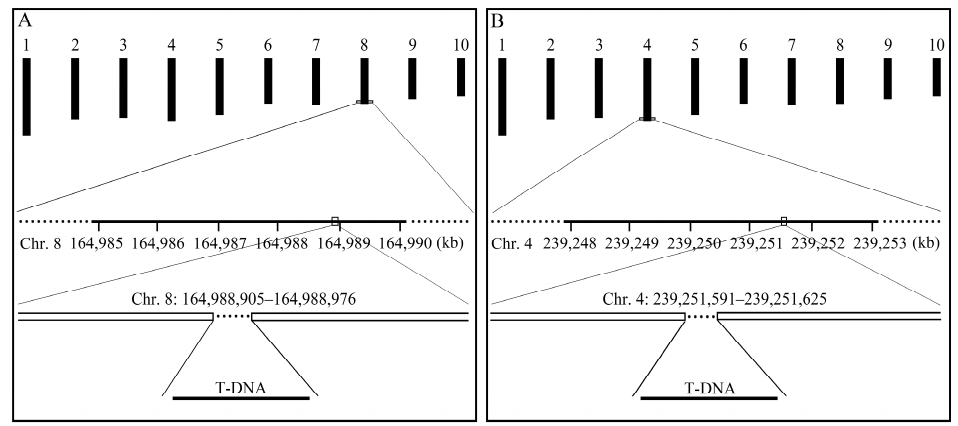
Figure 2. Schematic diagrams of the insertional T-DNA integrations in the CVC-1 ( A ) and CVC-2 ( B ) genomes. The upper part of the diagram displays ten chromosomes of maize. The numbers under the line of Chr.8 ( A ) and Chr.4 ( B ) indicate the physical positions on these chromosomes.